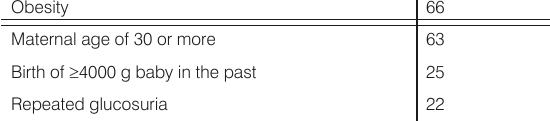
Table 3. Inadequacies of diabetic screening and/or treatment in pregnancies that resulted in shoulder dystocia associated neurological damage in the neonate.